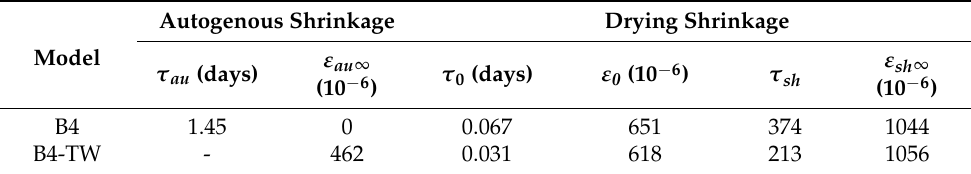
Table 9. Shrinkage parameters of prediction models B4,